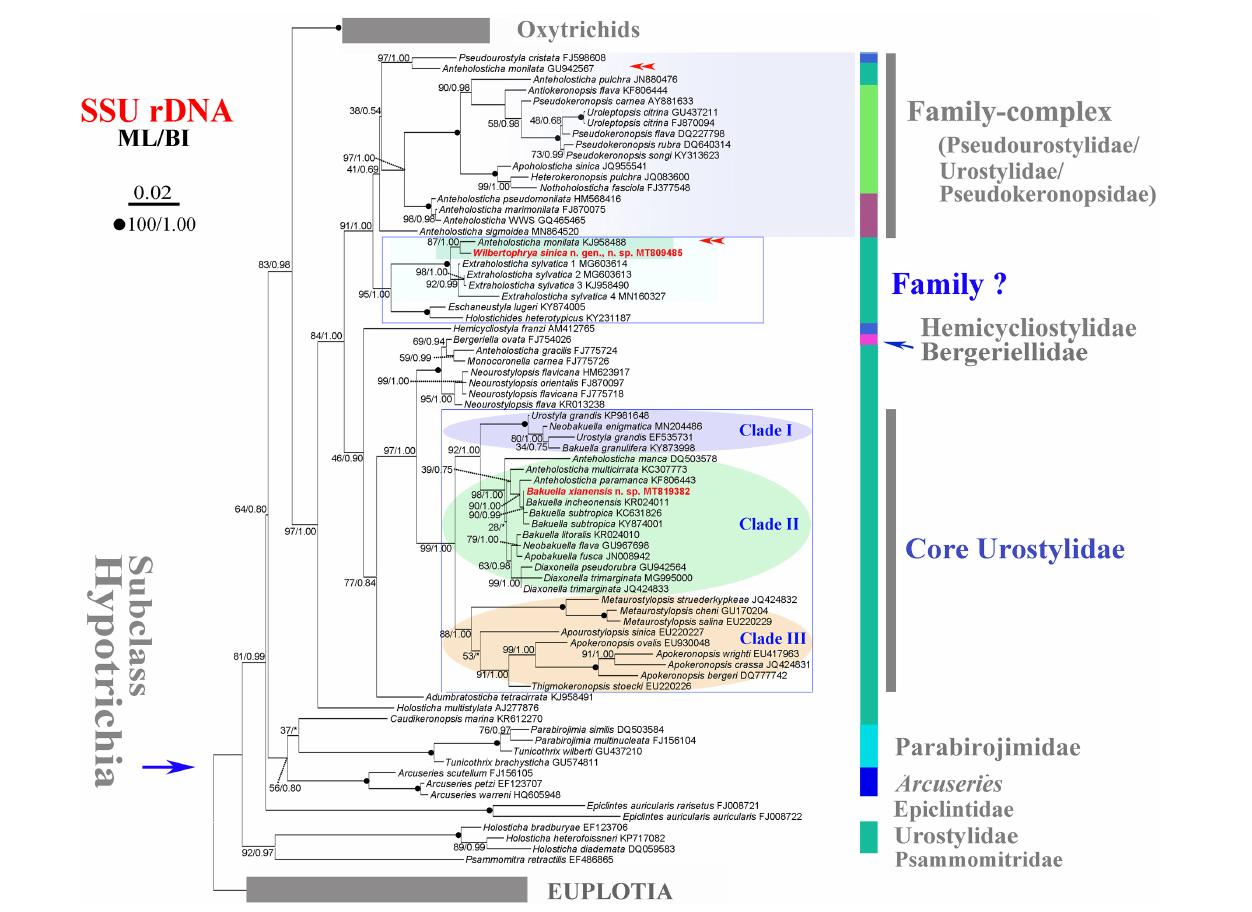
FIGURE 2 | Maximum likelihood (ML) tree inferred from the small subunit ribosomal DNA (SSU rDNA) sequences showing the position of Wilbertophrya sinica n. sp. and Bakuella xianensis n. sp. (in red) and related species (in rectangular boxes). Numbers near nodes are bootstrap values for maximum likelihood and posterior probability values for Bayesian inference (BI). “*” at nodes indicates disagreement between the two methods. Fully supported (100/1.00) branches are marked with filled circles. Double arrowheads mark the sequences with the same species name, of which one could be misidentified. The scale bar corresponds to 0.02 expected substitutions per site.